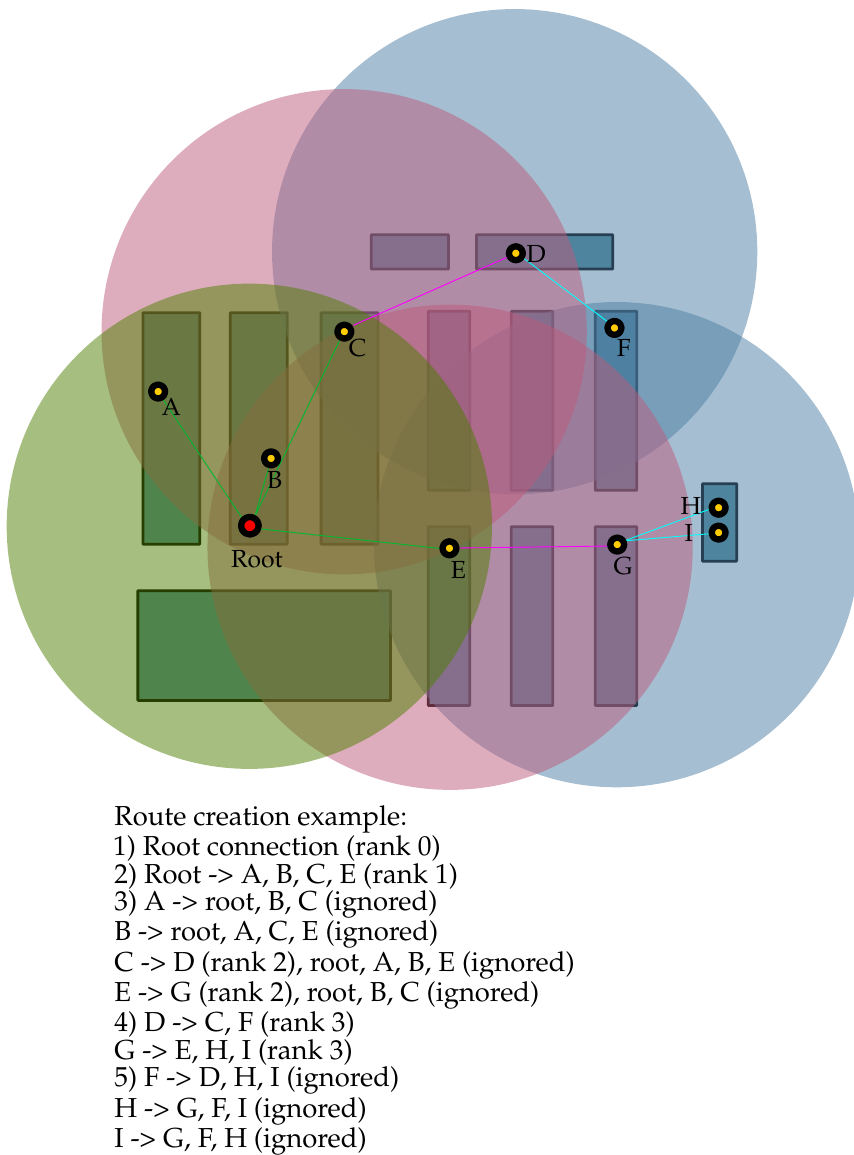
Figure 12. Example of network creation from the